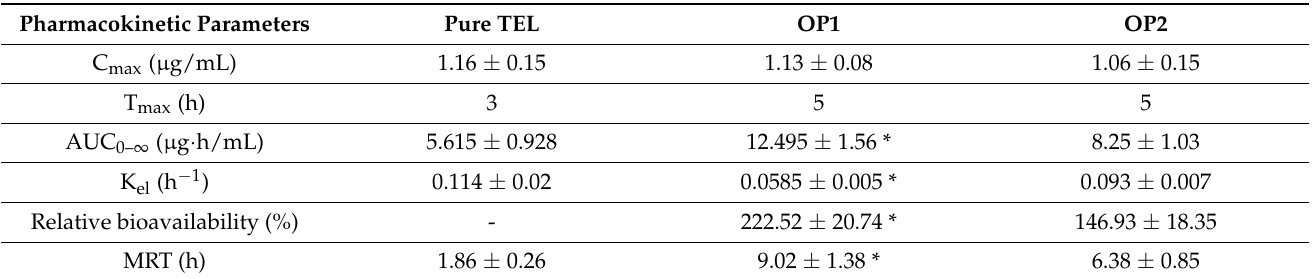
Table 10. The pharmacokinetic parameters of TEL, OP1, and OP2.